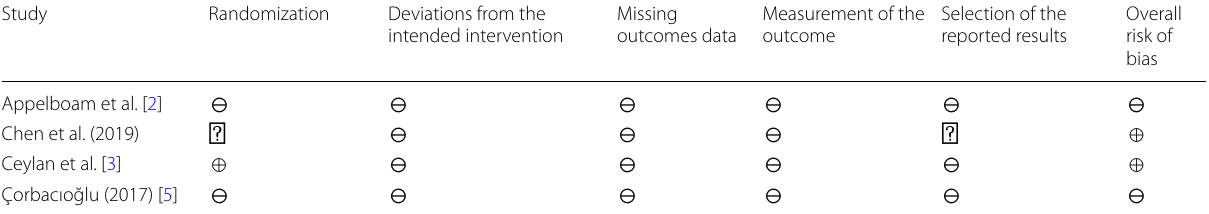
Table 1 Risk of bias